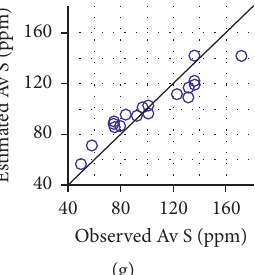
Figure 12: The goodness of fit of semivariogram models of selected soil properties using the cross-validation dataset. The straight lines represent 1 :1 proportion, that is, the difference between observed and predicted soil properties using the ordinary kriging and spherical semivariogram models. Table 4: Evaluation performance of kriging map of soil properties through cross-validation.